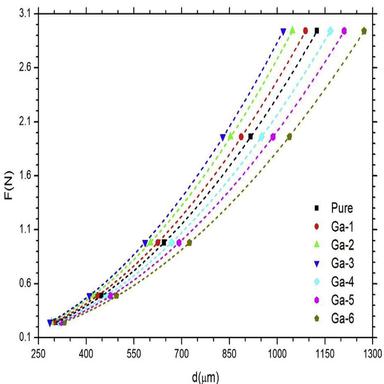
Variation of applied test load F over the diagonal length d for all the materials studied.